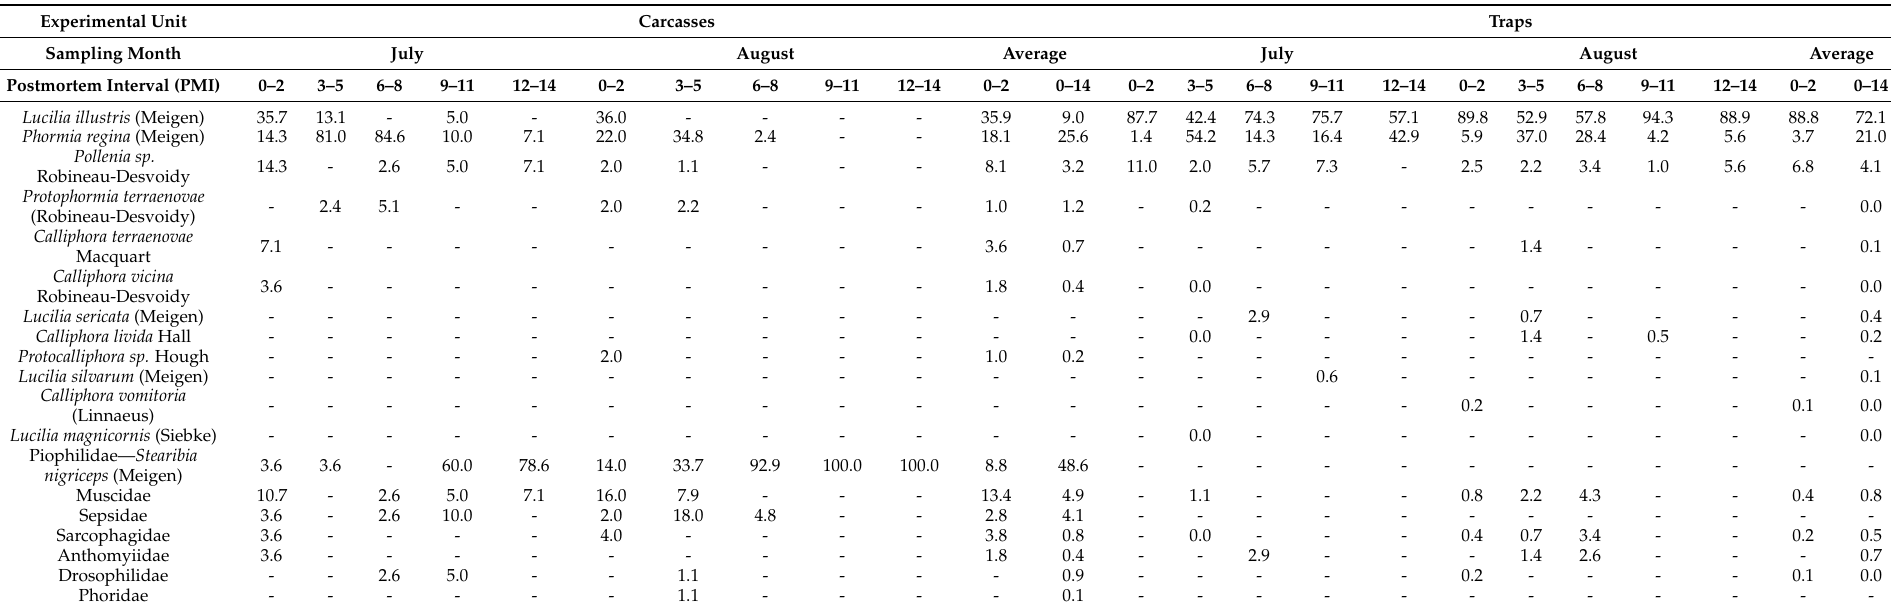
Table 1. Percentage of specimens of each species, genera and family of Diptera recovered during successive sampling intervals (PMI) from carcasses ( n = 4) and small traps baited with pork liver ( n = 4) in Cocagne, New Brunswick in July and August